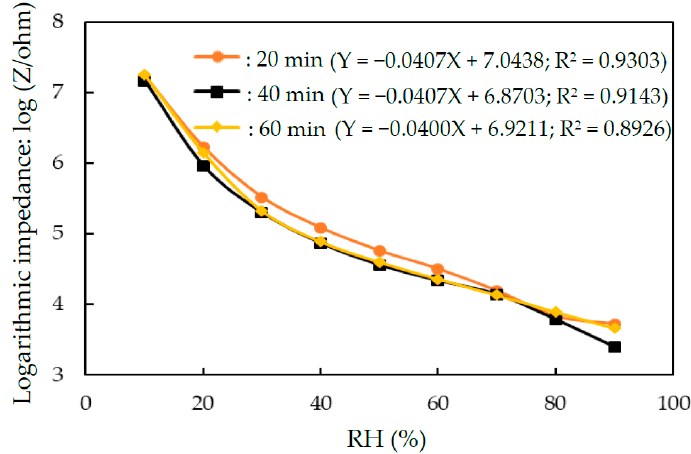
Figure 6. Impedance versus relative humidity for humidity sensors that were made of Ag MWs (6 mg)/PPy (0.1 g)/SnO 2 under various time of the UV-irradiation photopolymerization. (6 mg) / PPy (0.1 g) / SnO 2 under various time of the UV-irradiation